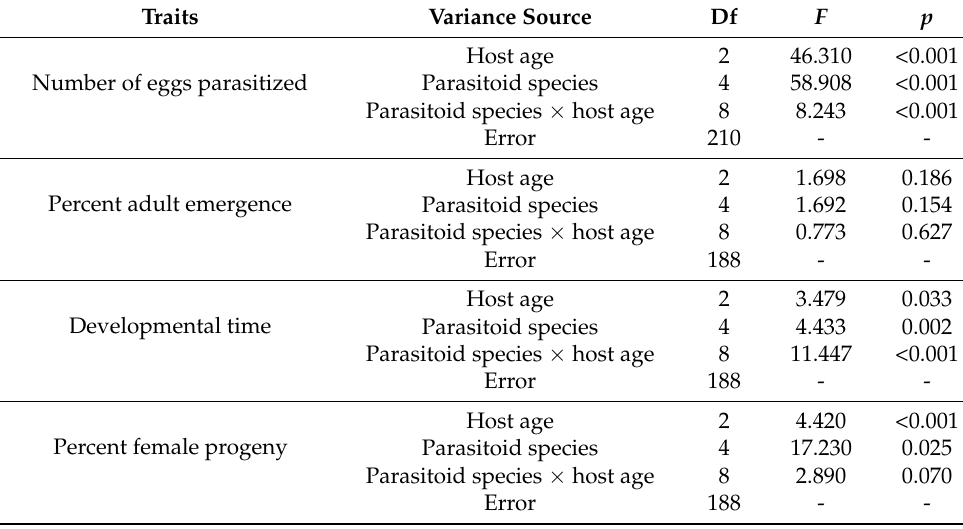
Table 1. Summary of the ANOVA analysis on effects of host age and parasitoid species on the number of eggs parasitized, percentage of adult emergence, developmental time, and percentage of female progeny of the five parasitoid species.